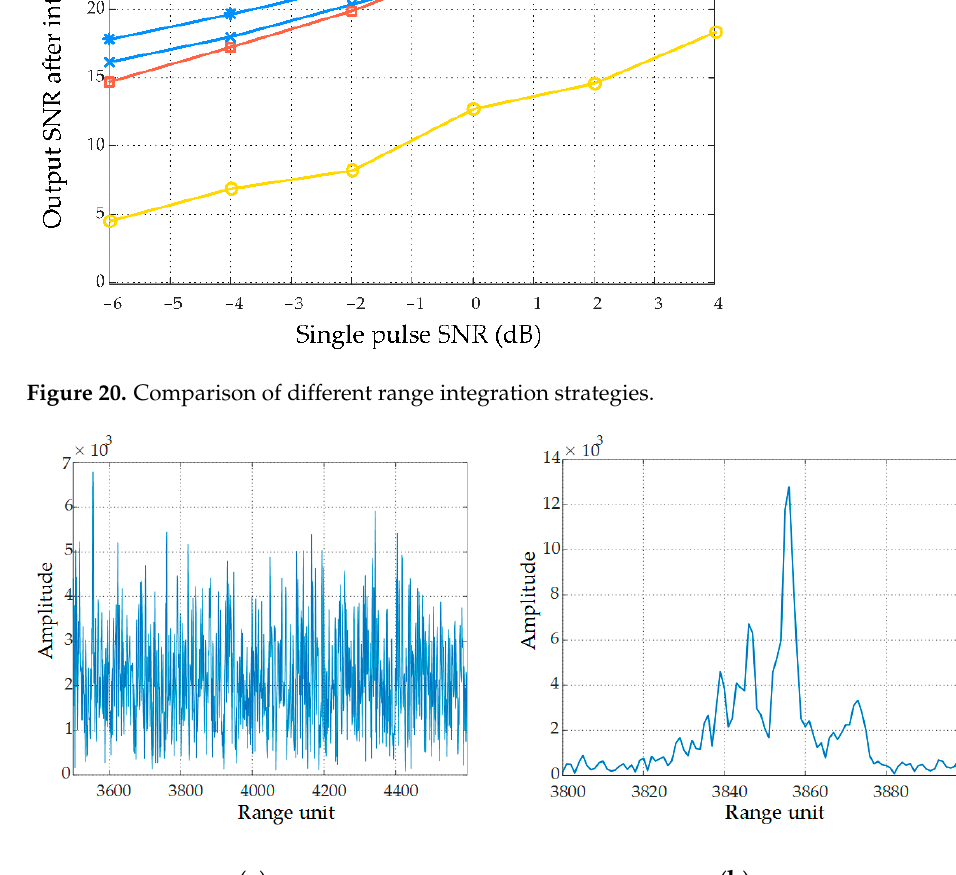
Figure 20. Comparison of different range integration strategies.